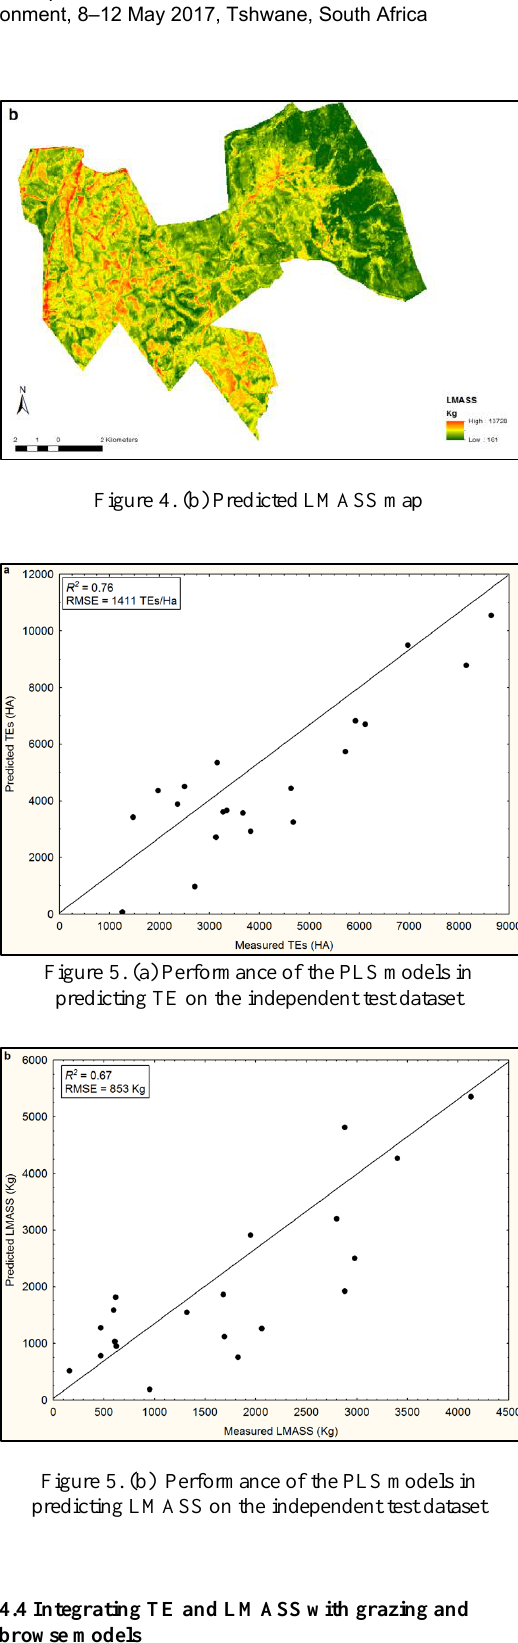
4.4 Integrating TE and LMASS with grazing